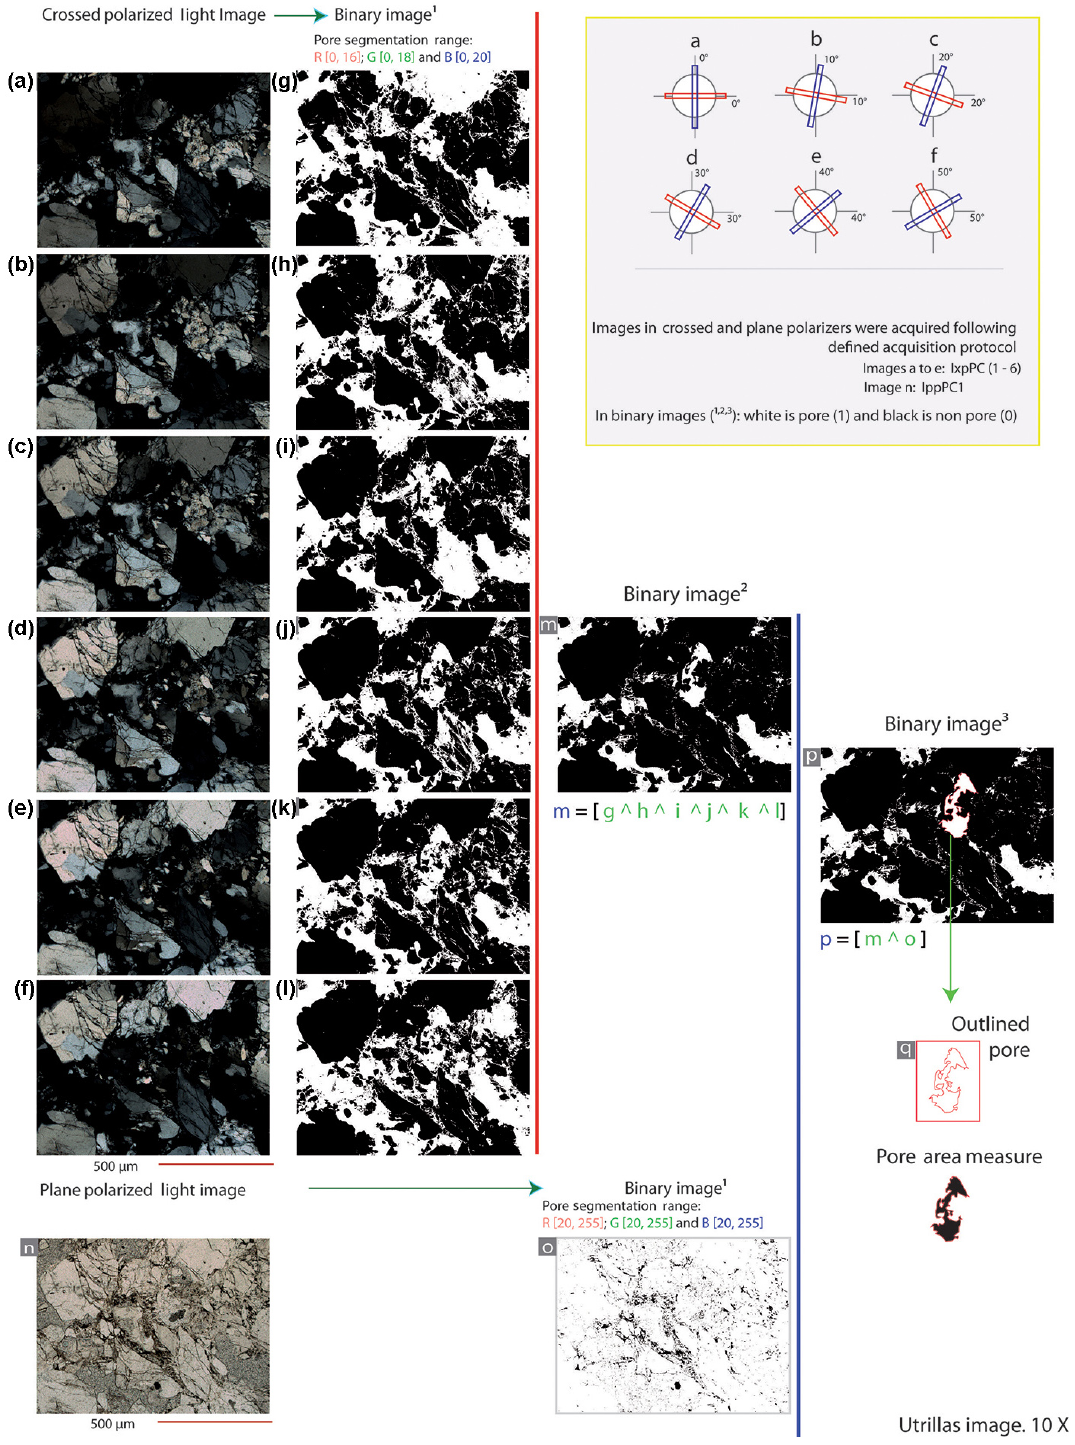
Figure 3. Schematic representation of the sequence of pore segmentation and pore area quantification performed on digital images (modified from Berrezueta el al., 2015) of the studied Utrillas sandstone. (a–f) Images under cross polarized light conditions. (g–l) Binary images 1 obtained using pore segmentation ranges: R(0–16); G(0–18) and B(0–20).m) Binary image 2 obtained by the interception of binary images 1 (g–l) . (n) Image under plane polarized light conditions. (o) Binary image 1 obtained using pore segmentation ranges: R(20–255); G(20–255) and B(20–255). (p) Binary image 3 obtained by the interception of binary images (m) and (o) . (q) Pore outlined image.